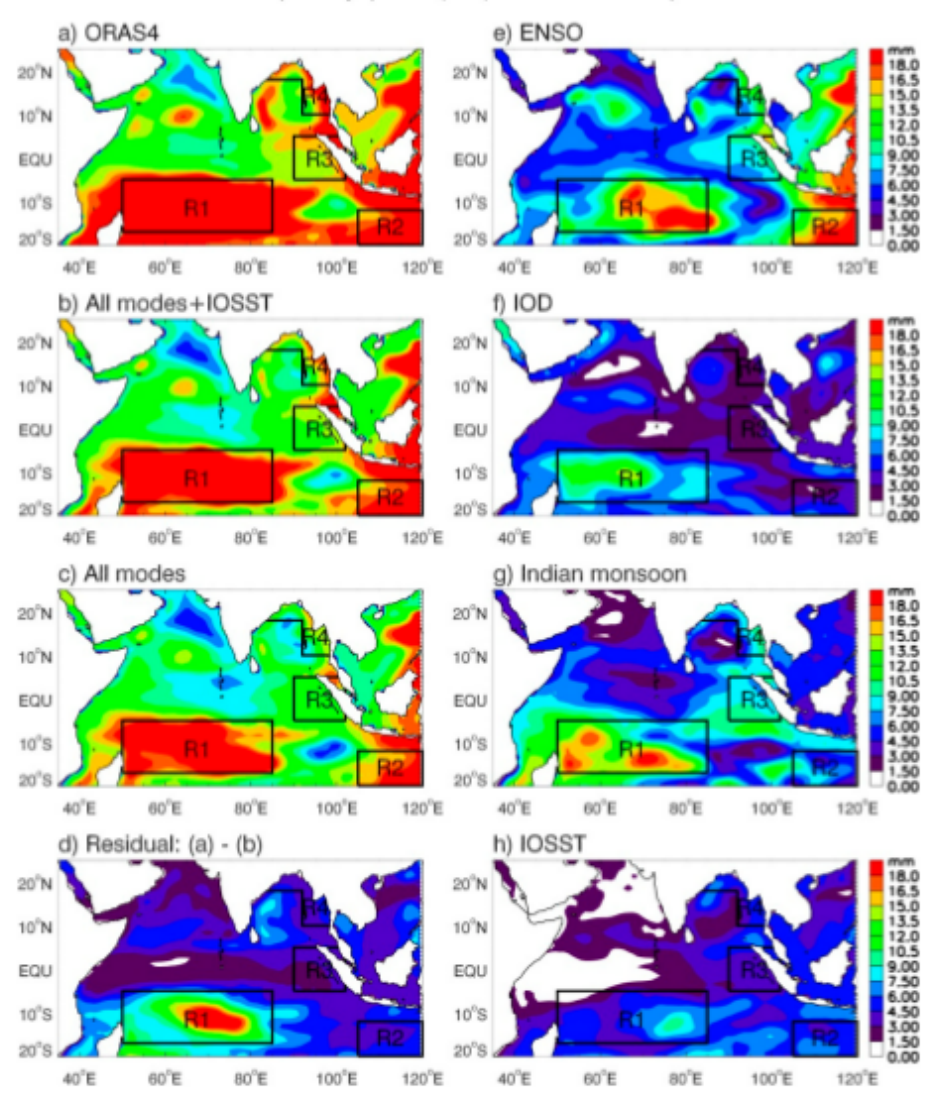
Figure 7. ( a ) The standard deviation map of the ORAS4 8 year low-passed SLA for the 1962–2011 period of the northern hemisphere winter season, based on the November–April averaged data of each year; ( b ) same as ( a ) but for SLA associated with all climate modes (ENSO + IOD + monsoon) plus the effect of IOSST which, to some extent, represents external forcing; ( c ) same as ( b ) but only for climate modes (ENSO + IOD + monsoon) and it equals the IOSST effect subtracted from panel ( b ); ( d ) same as ( b ) but for the residual, difference for ( a , b ), measuring the effects that cannot be explained by the climate modes and IOSST; ( e – h ) are the same as ( b ) but for the individual effect of decadal ENSO, IOD, monsoon, and IOSST. Units: mm. The figure is the same as Figure 6 except for northern winter